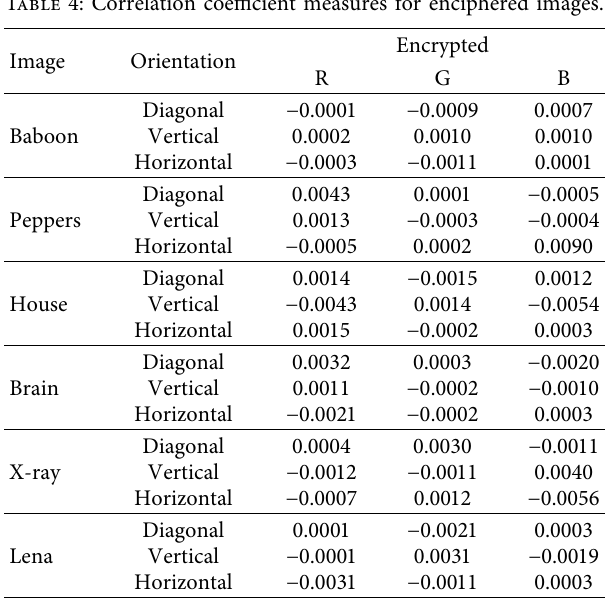
Table 4: Correlation coefficient measures for enciphered